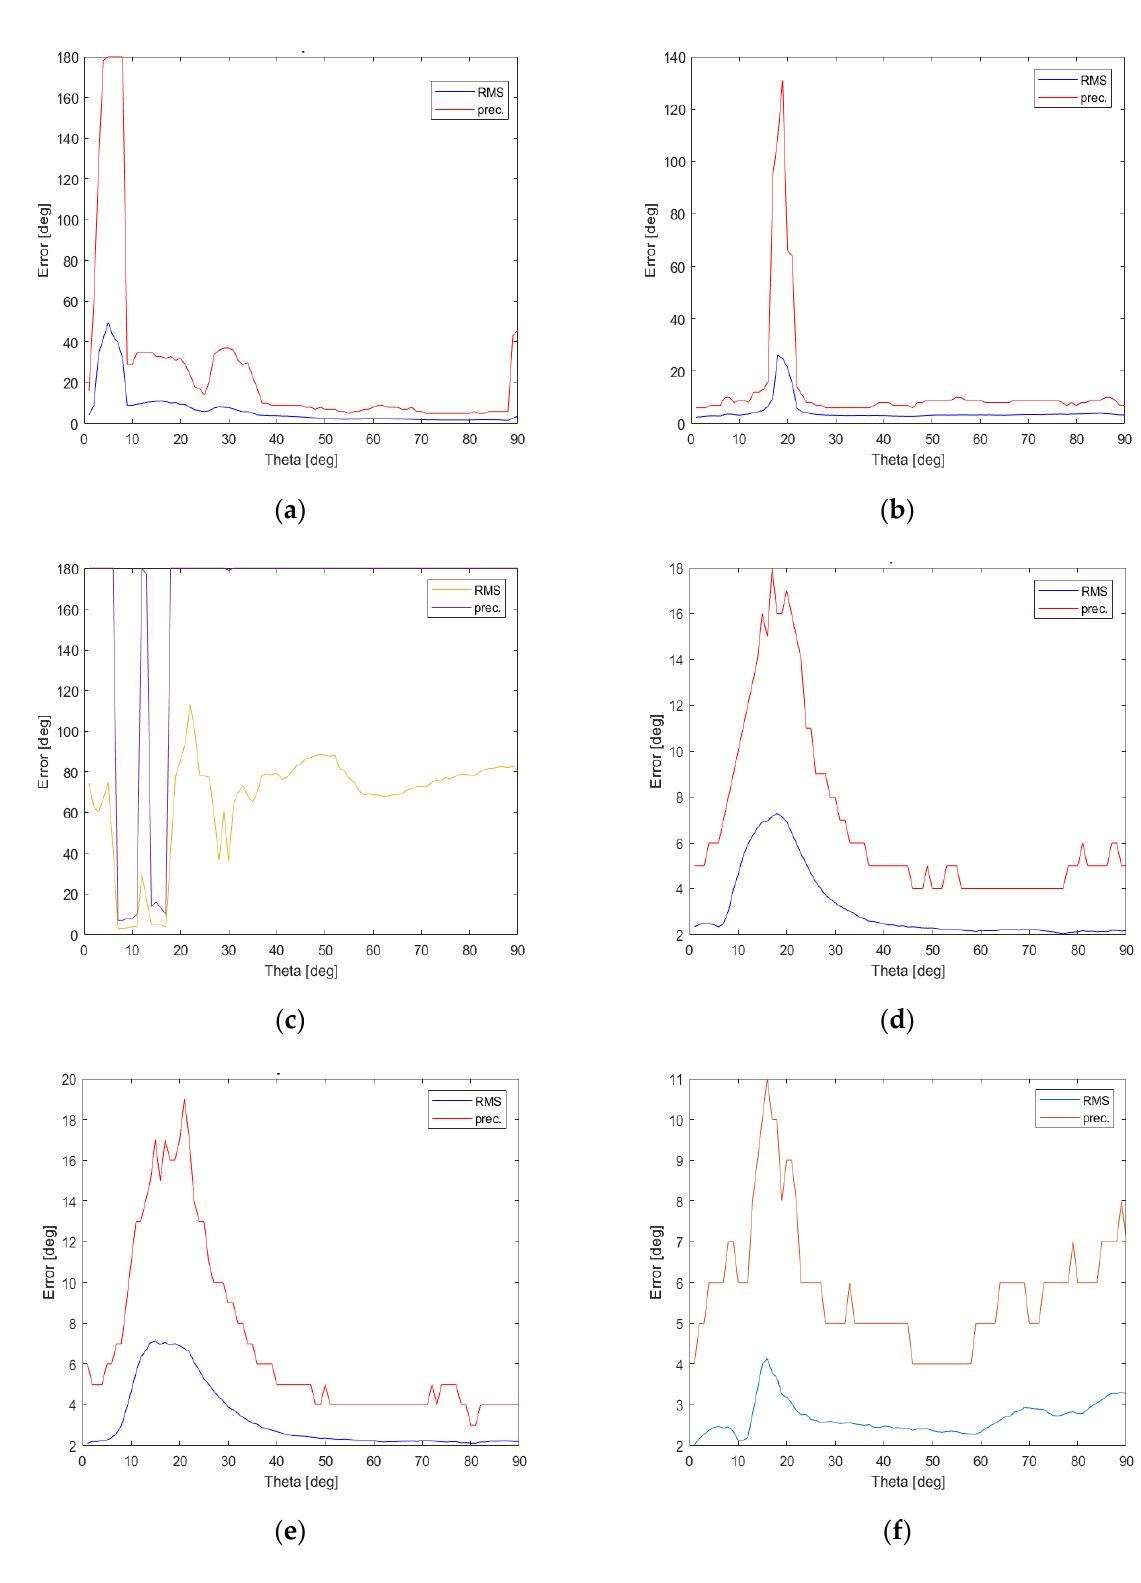
Figure 11. RMSE and precision values calculated using the proposed detailed DoA testing method, which involves all elevation angles during testing process, for the generalized PPCC-MCP algo- rithm relying on combinations of specific steering vector sets: ( a ) { V n up } ; ( b ) { V n mid } ; ( c ) { V n down } ; ( d ) { V n up , V n mid } ; ( e ) { V n up , V n down } ; ( f ) { V n mid , V n down }